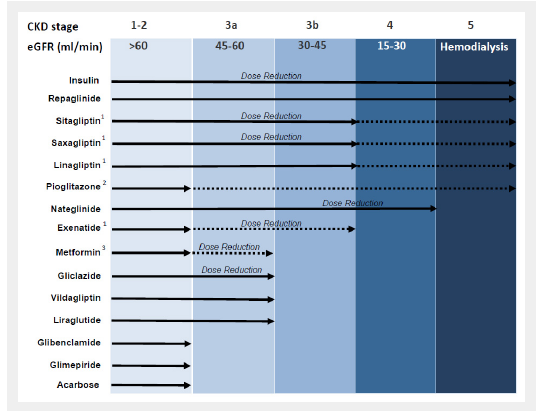
Antidiabetic treatment in chronic renal failure according to the KDIGO staging of CKD. Adapted from: Schernthaner G, Ritz E, Schernthaner GH. Strict glycaemic control in diabetic patients with CKD or ESRD: beneficial or deadly? Nephrol Dial Transplant. 2010;25:2044–7 [25] (© 2010, Oxford University Press. Reprinted with permission). Recommendations adapted to stages of CKD based on a consensus from pharmacological data, Swiss and international recommendations. 1 Limited experience (dotted line); 2 monitor for fluid retention;